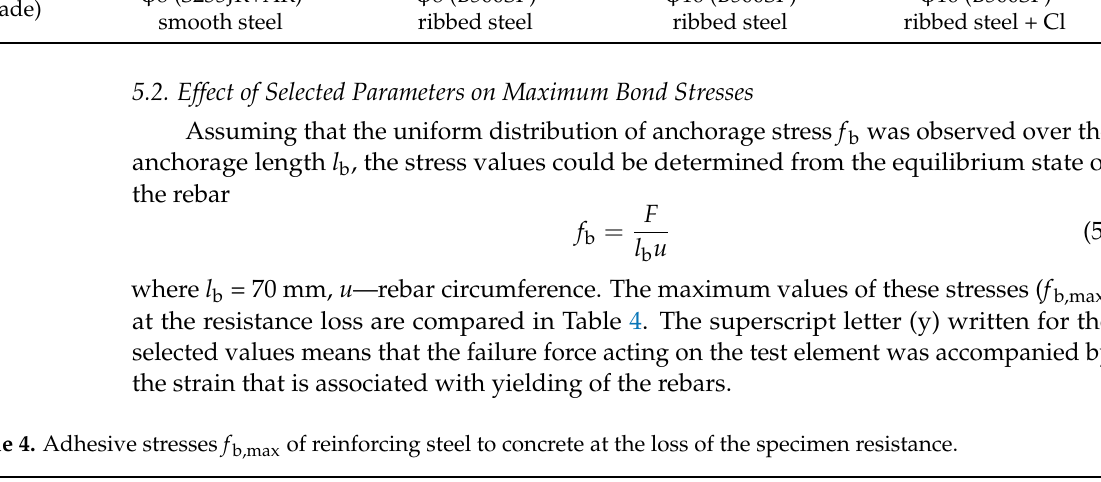
Table 4. Adhesive stresses f b,max of reinforcing steel to concrete at the loss of the specimen resistance. Time of Test (Day)